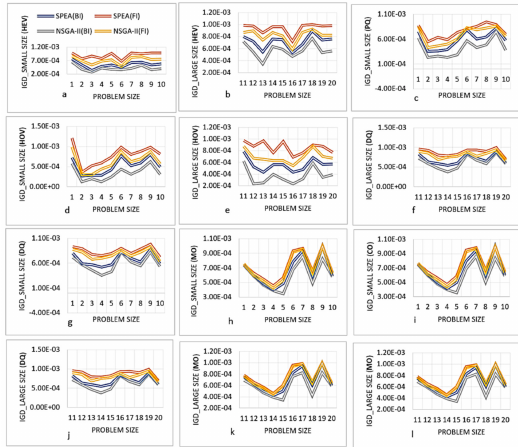
Figure 10. Inverted generational distance (IGD) scores for small and large problem instances of Heterogeneous vehicles ( a , b ), Homogeneous vehicles ( d , e ), perfect-quality products (PQ) ( c , f ), di ff erent-quality products (DQ) ( g , j ), monitoring only (Mo) ( h , k ) and conformity only (Co) ( i , l